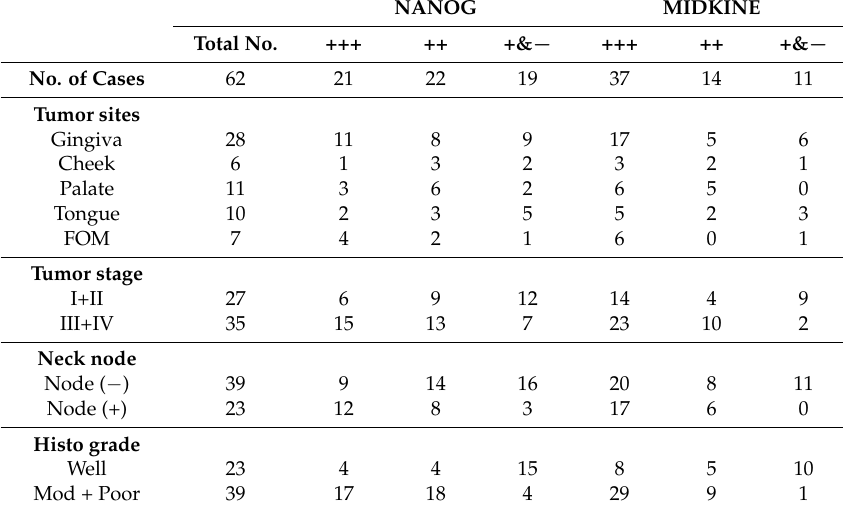
Table 1. Summary of clinicopathological features of oral squamous cell carcinoma (OSCCs) and immunohistochemical (IHC) expression patterns of NANOG and MIDKINE. NANOG